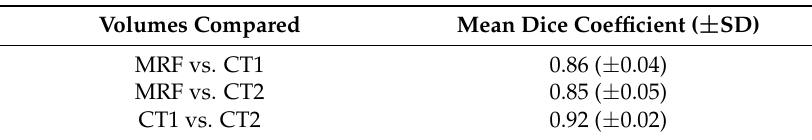
Table 3. Dice coefficients.